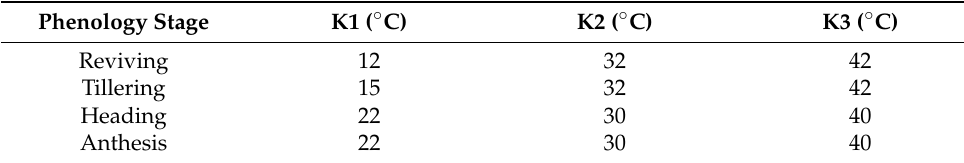
Table 1. The three-cardinal temperatures of the early